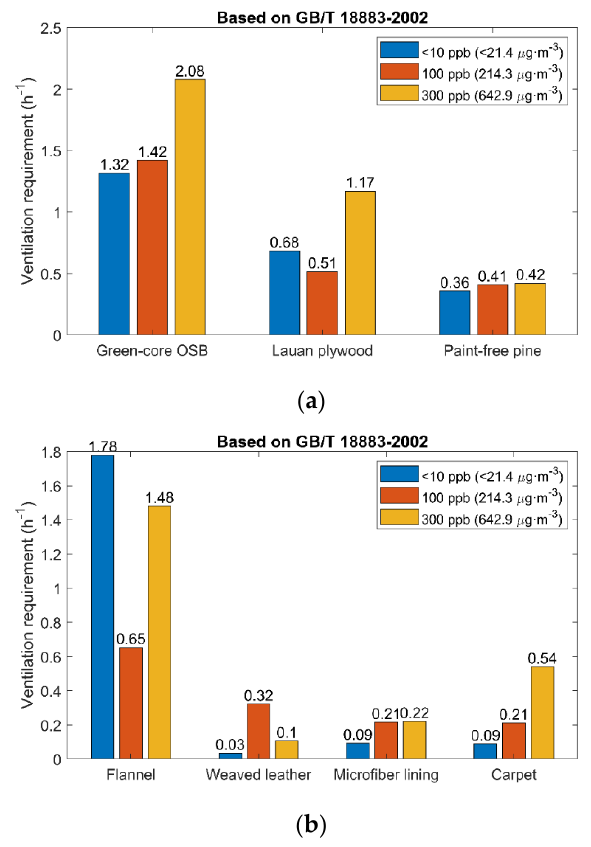
Figure 8. The ventilation requirements to dilute indoor VOC emissions with or without exposure to ozone. ( a ) Using wood-based panels as the indoor material. ( b ) Using synthetic fibers as the indoor material.